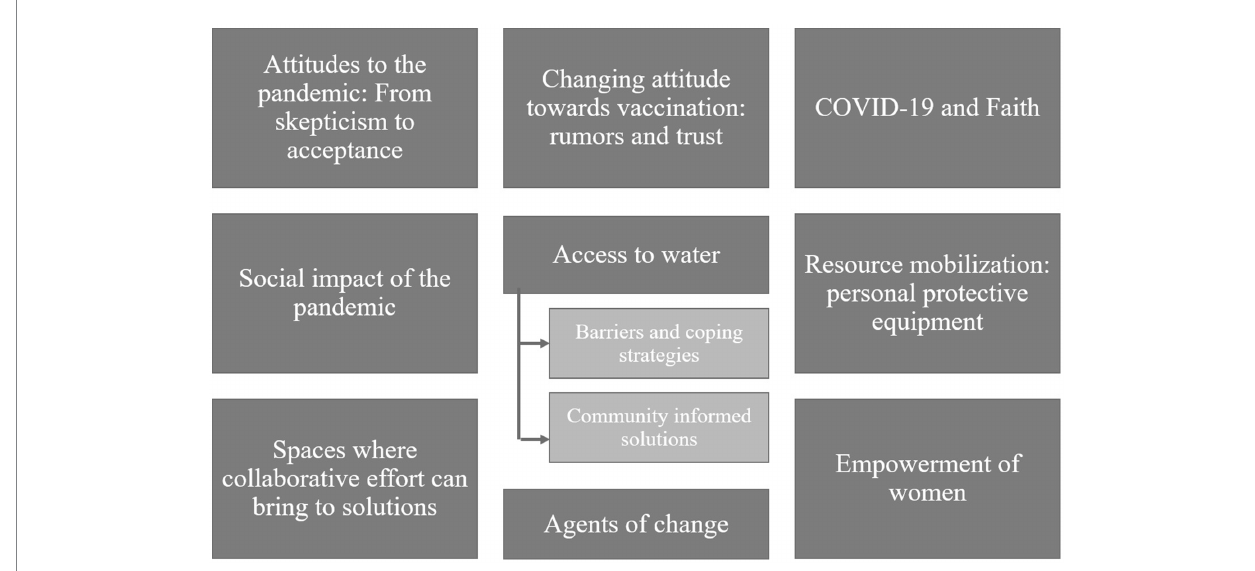
FIGURE 3 Key themes from the thematic analysis of the PAR meetings, focus group discussions and world café method with community members and health